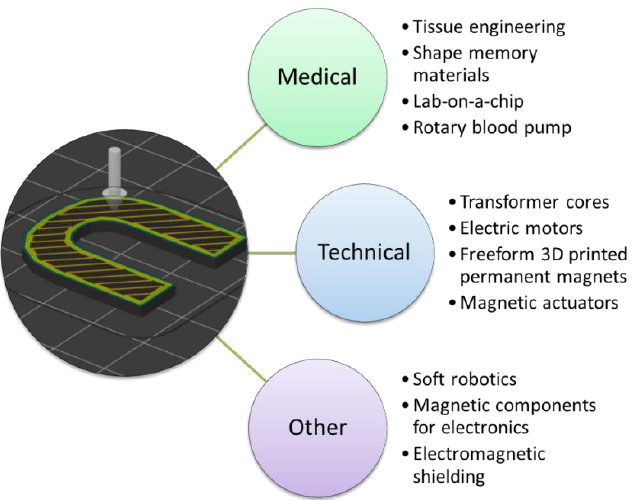
Figure 6. Overview of potential fields of application for 3D printed magnets.